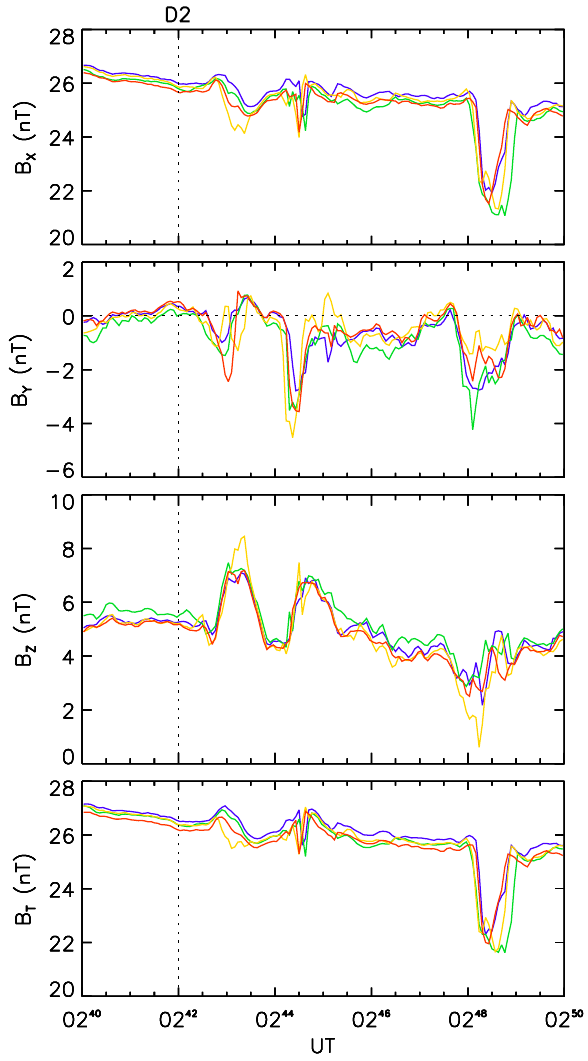
Fig. 11. Magnetic field components B x , B y , B z , and B T from all four Cluster spacecraft (blue, green, yellow, red are C1–C4, respec- tively), for the interval 02:40 to 02:50 UT, 29 August 2004.